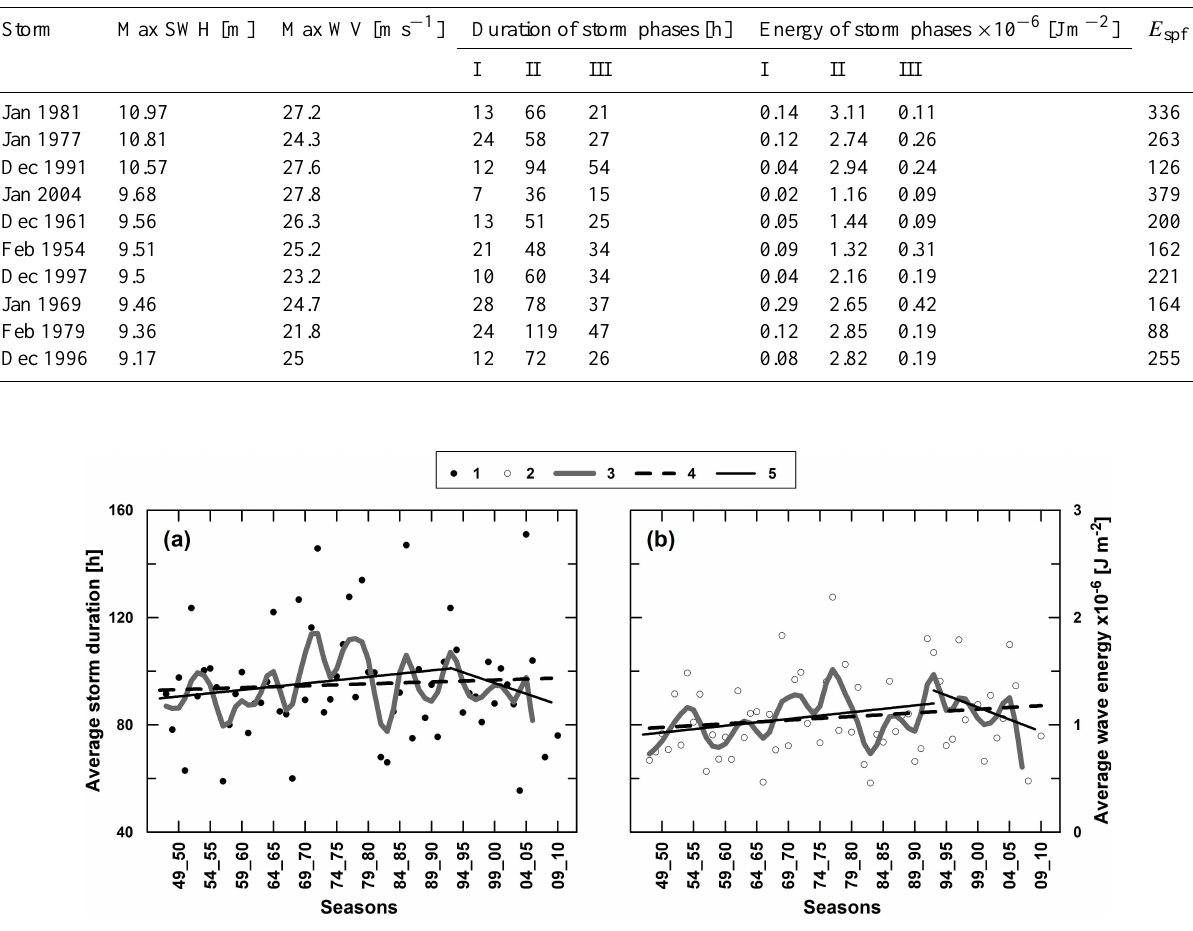
Fig. 5. Variability of average storm duration and average wave energy during 1948–2010; (a) average storm duration: 1 – data points, 3 – LPF approximation, 4 – global linear trend (0.072hdecade − 1 , R 2 = 0 . 003), 5 – local linear trends – upward (2.4hdecade − 1